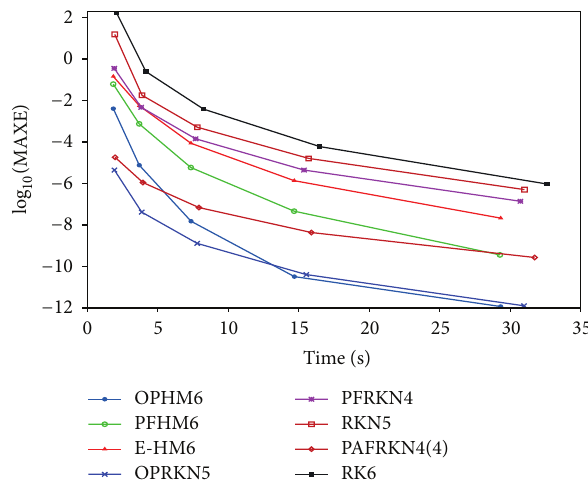
Figure 11: The efficiency curves of the optimized order six method = 10 4 and ℎ = and their comparisons for Problem 5 with 𝑡 end 0.125/2 𝑖 , 𝑖 = 2, ...,6 .